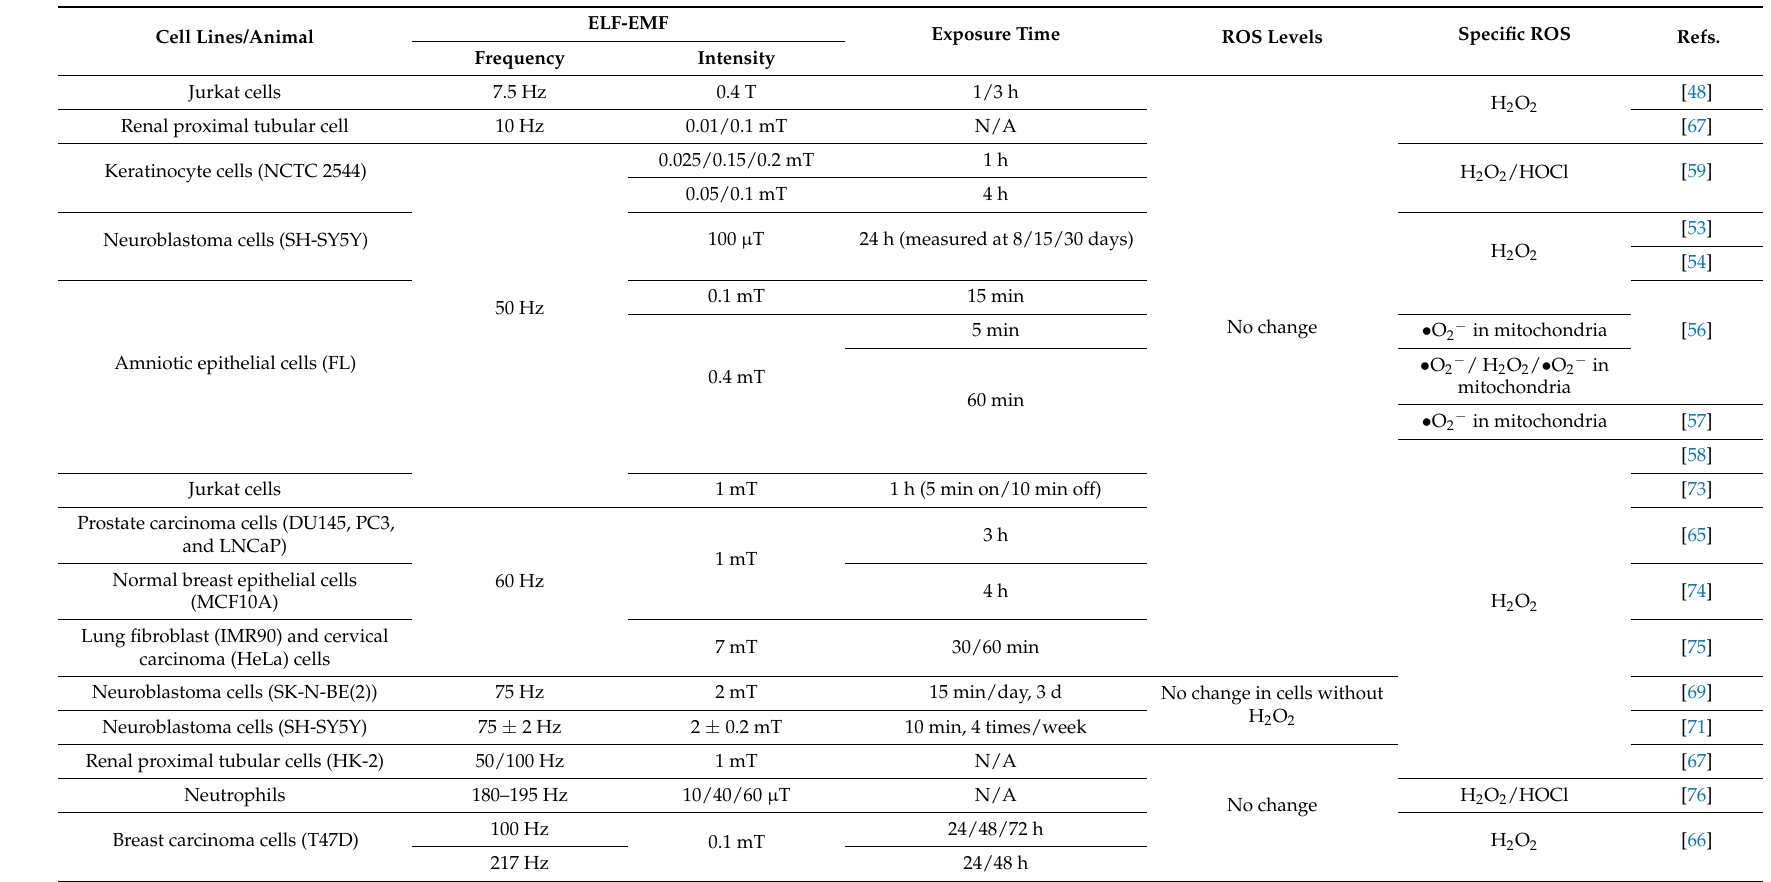
Table 3. ROS levels were not changed by ELF-EMFs in some human